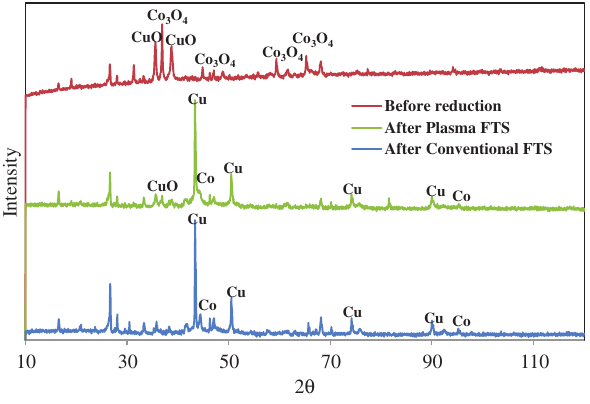
Figure 3 XRD histogram of Co/Cu catalyst supported on aluminosil- icate before reduction and after reaction with and without